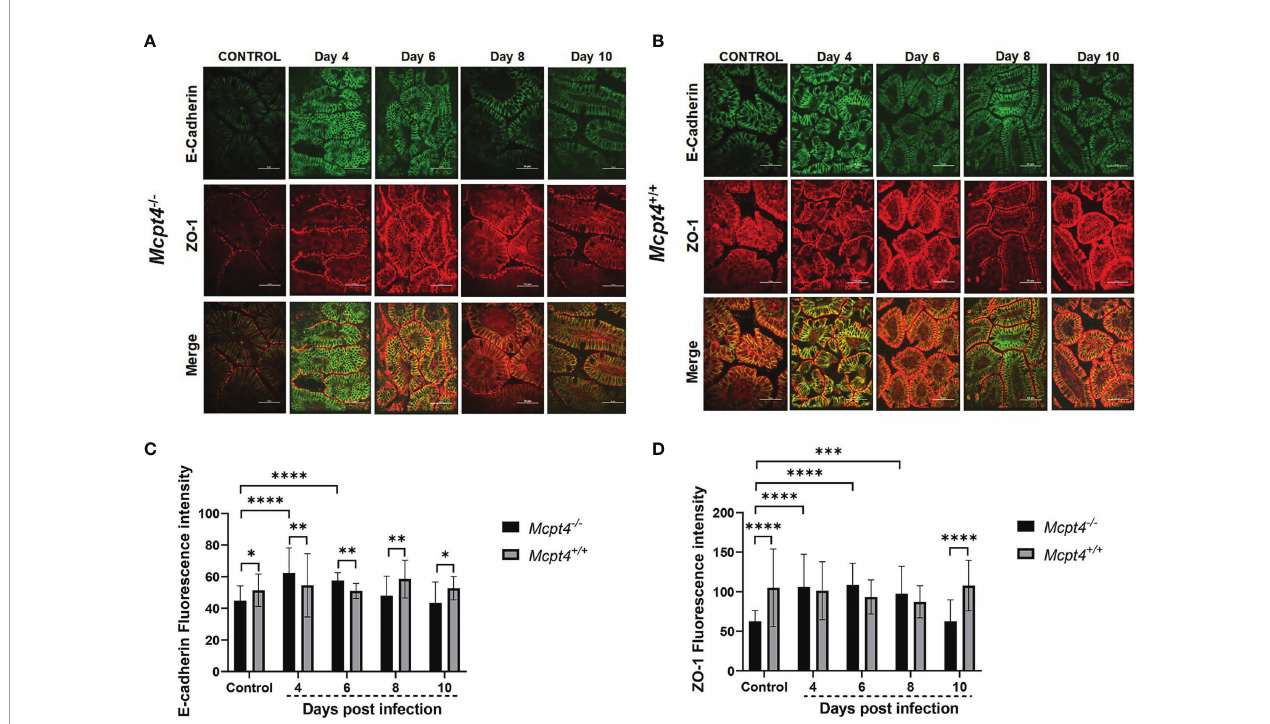
FIGURE 3 | Mcpt4 -/- mice exhibited altered patterns of ileal adherens junctions during P. y. yoelii 17XNL infection relative to Mcpt4 +/+ mice. Representative images from P. y. yoelii 17XNL-infected Mcpt4 -/- (A) and Mcpt4 +/+ (B) mice and uninfected controls. The top, middle and bottom rows contain images of E-cadherin (green) and ZO-1 (red) staining and merged images. Scale bars represent 50 m m length. Quantitation of E-cadherin (C) and ZO-1 (D) . Quantitative analysis of fl uorescence was performed using NIH ImageJ software. Data are represented as mean ± SD from 10-15 HPF per mouse from three independent biological replicates (n=5 Mcpt4 -/- mice and n=5 Mcpt4 +/+ mice per replicate). Data were analyzed with the Kruskal-Wallis test followed by Dunn ’ s multiple comparison for each time point versus control or between Mcpt4 -/- and Mcpt4 +/+ mice at speci fi c time points. P values ≤ 0.05 were considered signi fi cant. *P ≤ 0.05, **P ≤ 0.01, ***P ≤ 0.001, ****P ≤